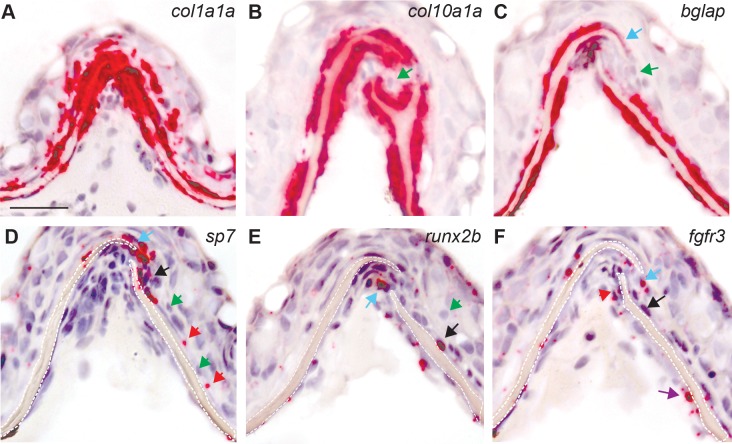
RNA detection for genetic markers of osteoblasts in juvenile animals assessed using RNAscope in situ hybridization on paraffin section.(A-F) Sequential sections (4 μm) of the interfrontal suture collected from juvenile zebrafish at age of 6 wpf. The expression of individual genes is visualized in red, counterstained with haematoxylin for nuclei in purple; black arrows examples of positive expression, all green arrows indicate negative for expression cells. (A) The expression of col1a1a is present in all cells. (B) The green arrow indicates cells that are negative for col10a1a expression in the mid-suture domain. (C) Expression of bglap weaker at the tips of frontal bones as indicated by blue arrow. (D) Expression of sp7 at osteogenic fronts (blue arrow) and along the frontal bone (red arrow), (E) runx2b at the osteogenic front (blue arrow) and along the bone (black arrow). (F) fgfr3 expression observed in osteogenic front (blue arrow) and along the frontal bones (black and purple arrows). The scale bar represents 20 μm.